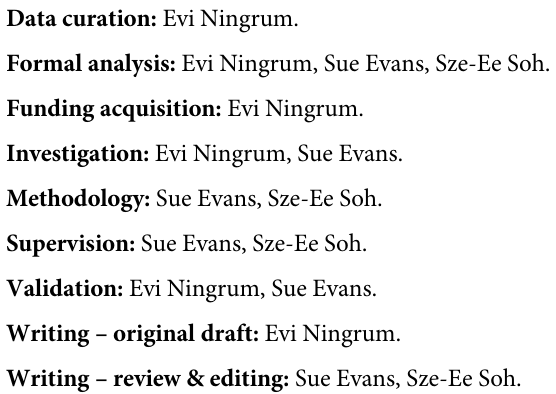
S1 Fig. Thresholds maps for the SAQ-INA domains. S2 Fig. Person-item thresholds distribution for all SAQ-INA